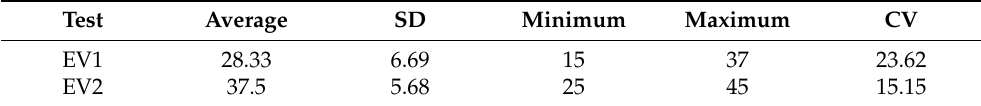
Table 2. The mean value of the Berg Table 4. Table of average differences of the Berg scale. Table 4. Table of average differences of the Berg scale.